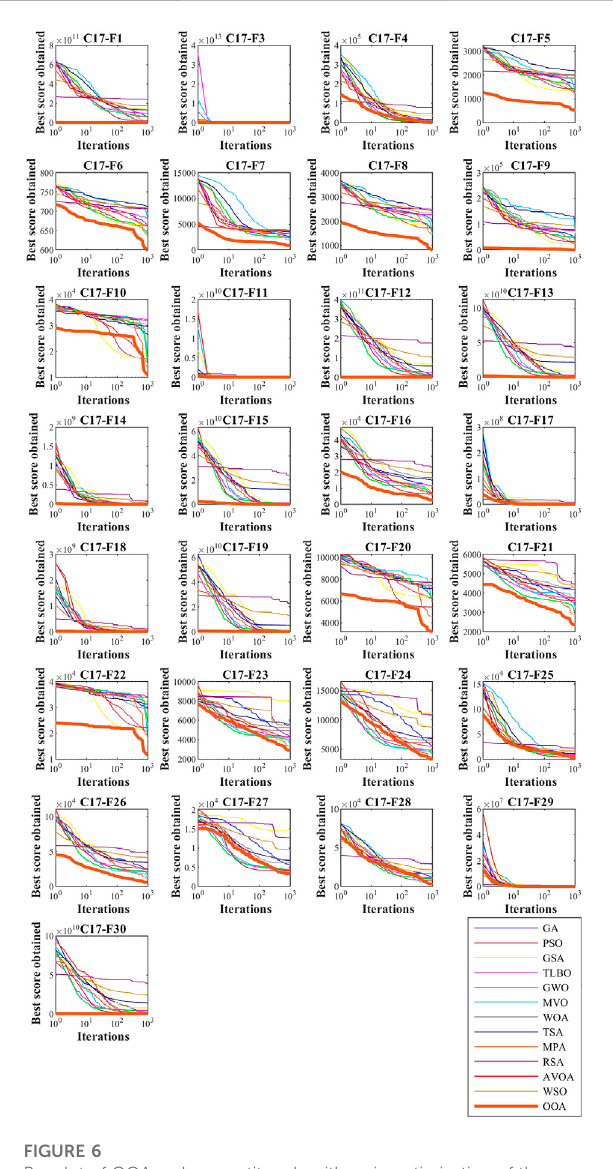
FIGURE 6 Boxplot of OOA and competitor algorithms in optimization of the CEC-2017 test suite ( D (cid:1) 100